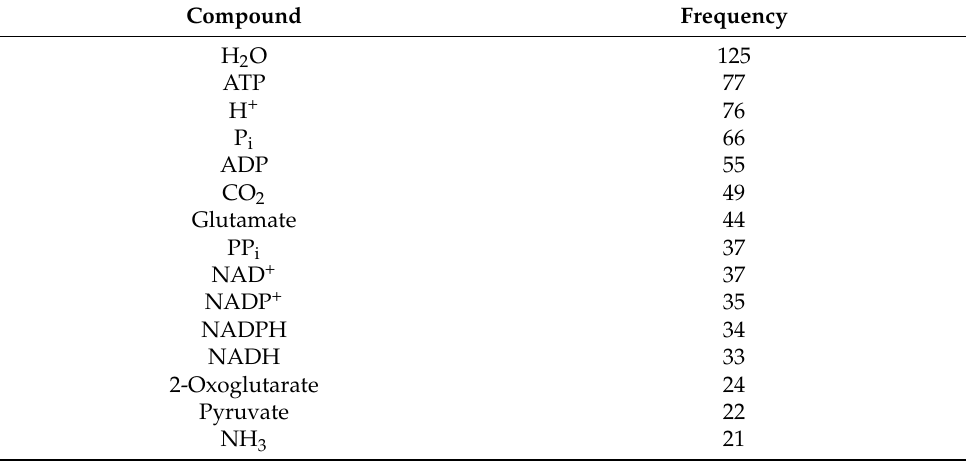
Table 1. Highly connected